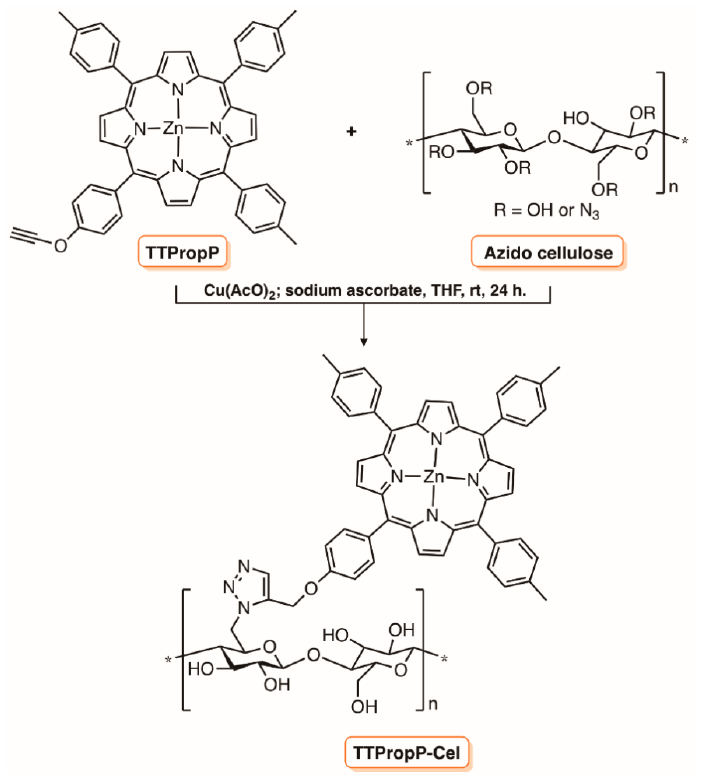
Figure 23. Synthetic methodology used to covalently graft the acetylenic porphyrin TTPropP in azido cellulose fabric (adapted from Reference [130]).